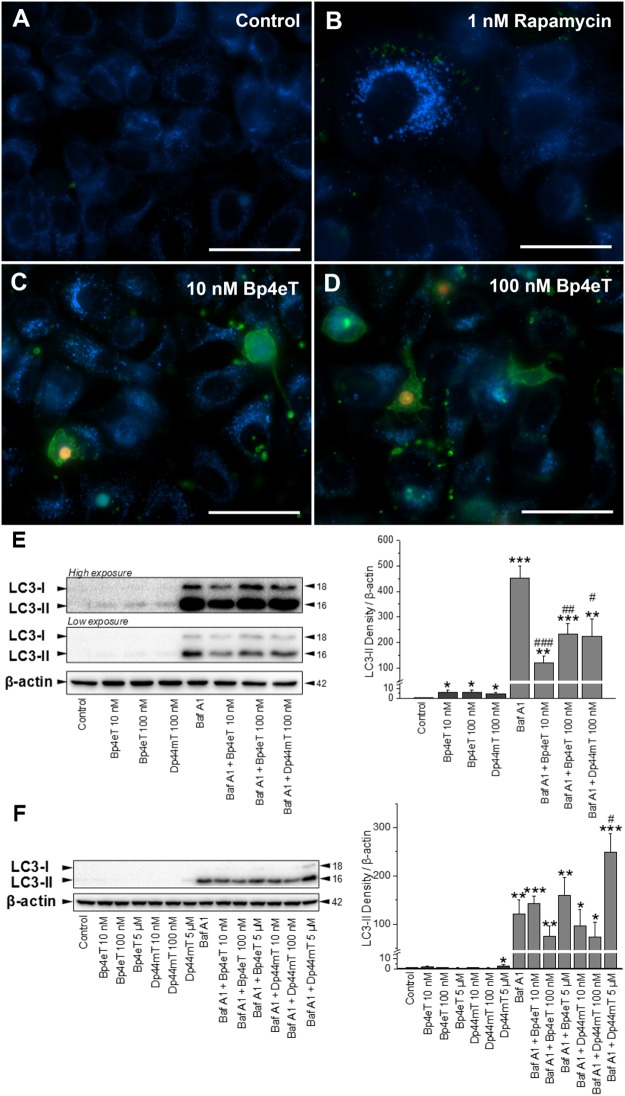
Epifluorescence microscopy and immunoblot estimation of autophagy, apoptosis, or necrosis after incubation with Bp4eT.MCF-7 cells were incubated at 37°C with either: (A) Control medium for 72 h; (B) Rapamycin (1 nM) for 30 min to serve as a positive control for autophagy; or (C, D) 10 or 100 nM Bp4eT for 72 h. Scale bars represent 50 μm. (E) MCF-7 cells were incubated for 72 h/37°C with either: control medium, or medium containing 10 or 100 nM Bp4eT, 100 nM Dp44mT, or 100 nM Bafilomycin A1 alone, or the combination of chelators and Bafilomycin A1. Western blotting and subsequently densitometry was then performed to assess LC3-I/II expression. As there was a marked difference in ability of Bafilomycin A1 and the chelators to up-regulate LC3-II levels, the blots are shown at both low and high exposures. (F) MCF-7 cells were incubated for 24 h/37°C with either: control medium or this medium containing either: Bp4eT (10 nM– 5 μM), Dp44mT (10 nM– 5 μM), or Bafilomycin A1 (100 nM) alone, or the combination of the chelators and Bafilomycin A1. Western blotting and densitometry were then performed. The western analysis in (E) and (F) are typical from 3 experiments, while the densitometric analysis is mean ± SD (3 experiments) normalized to β-actin. *p < 0.05, **p < 0.01, ***p < 0.001 versus control. #
p < 0.05, ##
p < 0.01, ###
p < 0.001 versus Bafilomycin A1 alone.